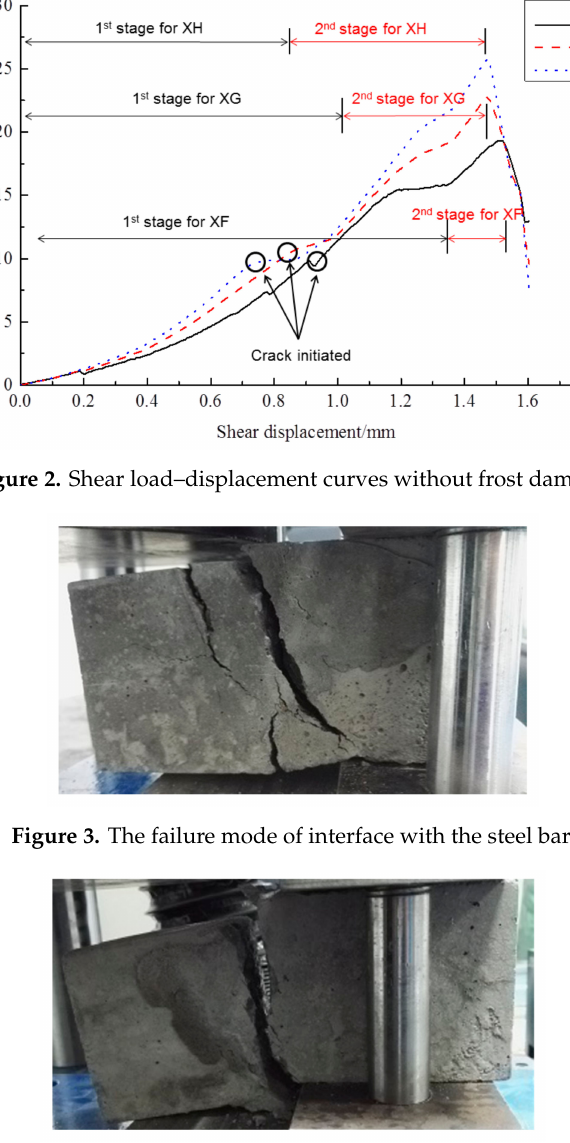
Figure 4. The failure mode of interface without the steel